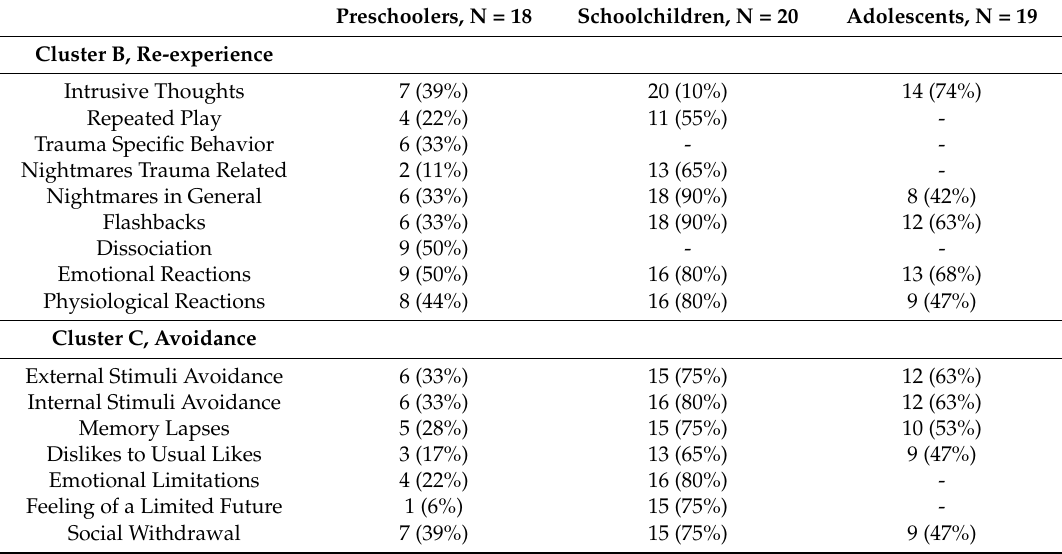
Table 1. Descriptive statistics of Post-Traumatic Stress Disorder (PTSD) symptoms for the age